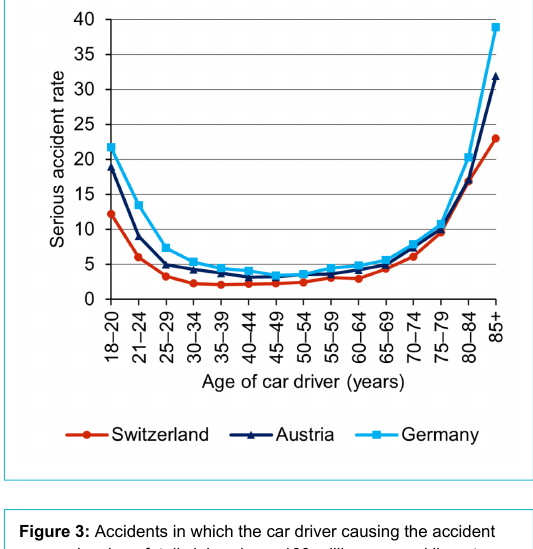
Figure 2: Serious accidents (at least one person seriously or fatal- ly injured) caused by car drivers, per 100 million person kilometres driven, by age group of car driver and country (analysis 1). The corresponding numerical values including 95% confidence inter- vals can be found in the appendix (supplementary table S1).